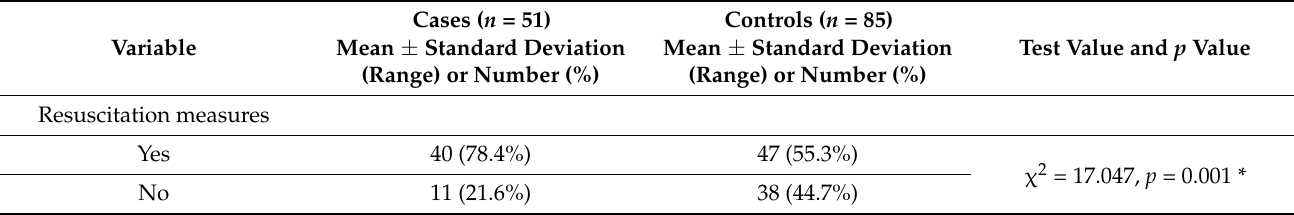
Table 4. Conducted therapeutic measures in